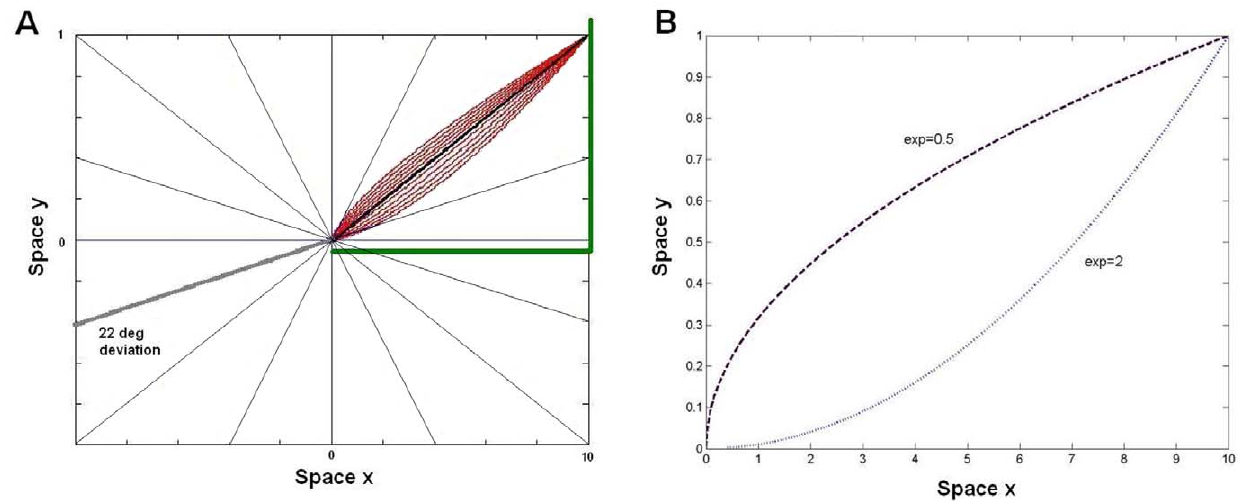
Figure 3. Trajectories used in Experiment 1 and the shapes of different exponents. A. A sample trajectory used in the experiment. Space is represented in arbitrary units. The second half of the trajectory was fixed for all deviation angles (45 deg from horizontal, black solid line) but the initial direction of motion was varied according to different deviation angles. The first half of the trajectory for 22 deg deviation is shown by a thick gray line. Observers reported the perceived curvature (curves around the black solid line) in the second portion of the trajectory after each trial. Thick orthogonal lines were placed for reference to facilitate the judgment of the perceived curvature. B. The shapes of second halves of trajectories that observers used for reporting their perception, for sample exponent values. The x and y axes represent space, and two different trajectories are shown having exponents of 0.5 and 2. The x axis length is identical for all trajectory shapes and the y axis is computed according to y=y max *(x / x max ) exponent , where y max and x max are constants (8.8 arcdeg.). Equivalently we can express the relationship using the differential equation dy/ dx=y